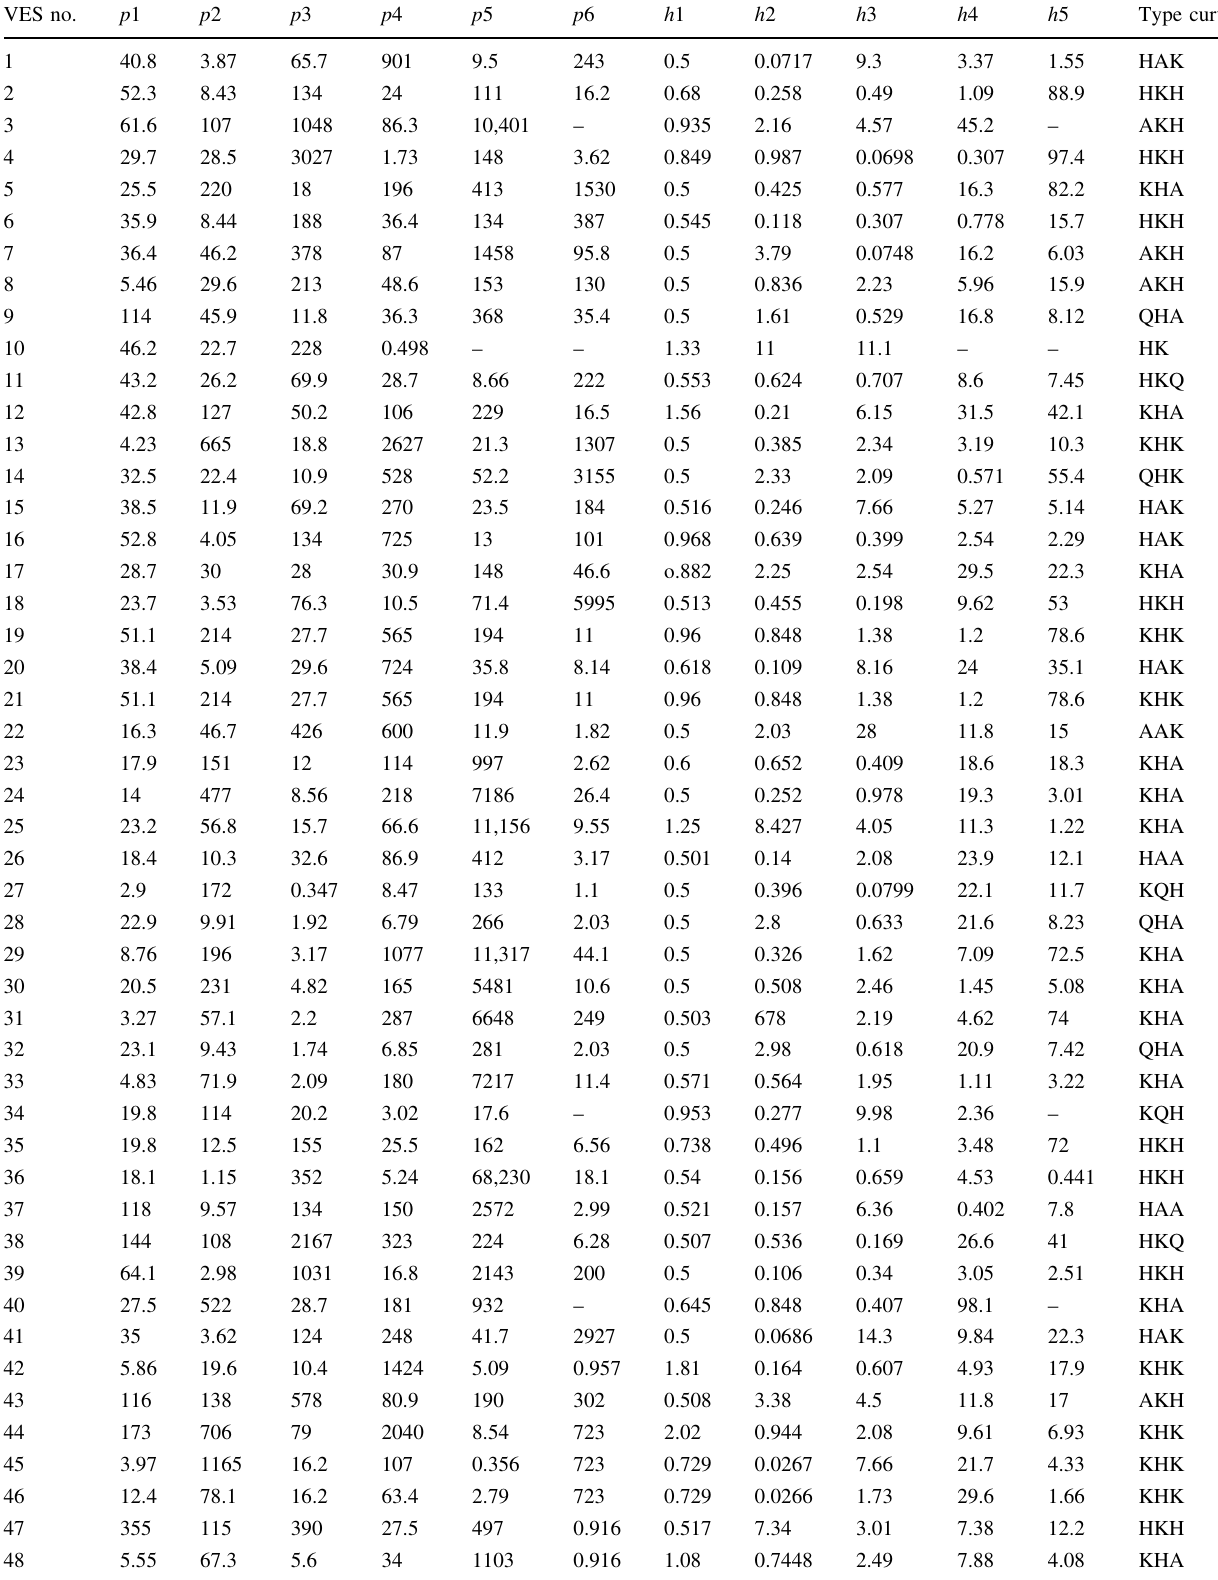
Table 4 Resistivity values and thickness of different layers at all VES locations from Dhule district (Schlumberger method) VES